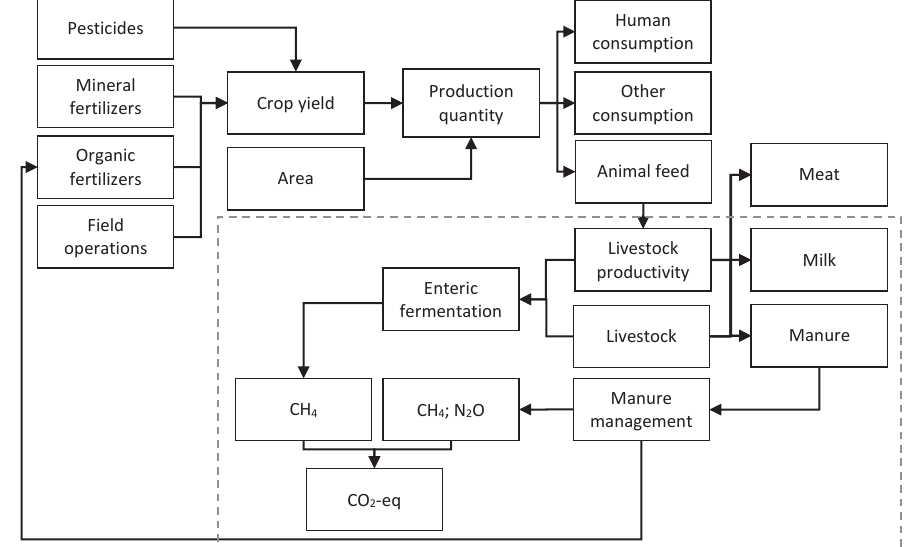
Fig. 1. Simplified block scheme of the Estonian agricultural model (crop and animal production) and sources of GHG emissions from animal production (dashed line depicts the bounds of the analysis). Source: Authors’